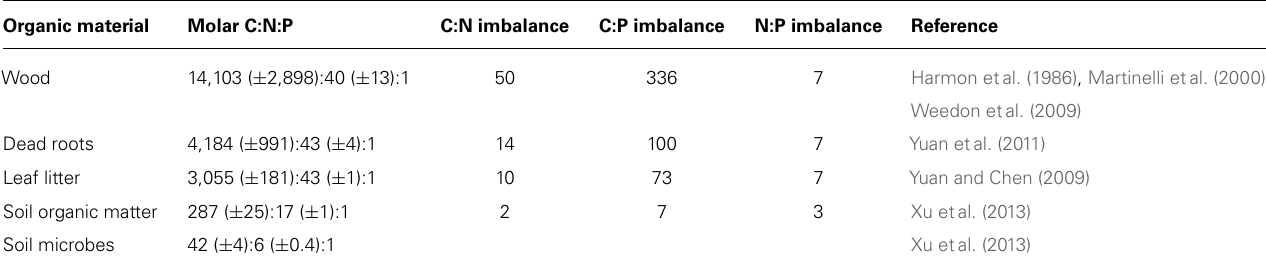
Table 1 | Globally averaged element ratios in potential resources and in soil microbial biomass, and stoichiometric imbalances between resources and microbes calculated as the ratio of C:N resource (or C:P, N:P) over C:N microbes (or C:P, N:P). Organic